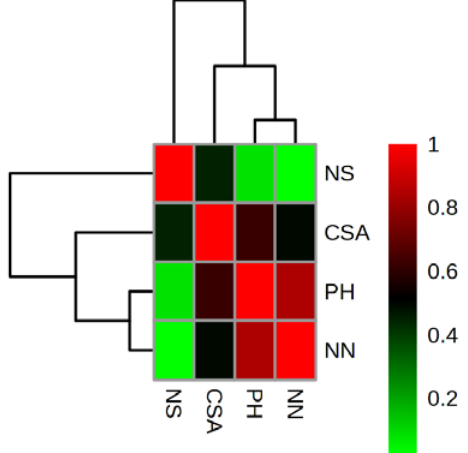
Figure 5. Heat map correlation among the in vitro morphological parameters (plant height (PH), number of nodes (NN), number of shoots (NS), and canopy surface area (CSA)) during in vitro prolonged culture of cannabis explants derived from different parts of the greenhouse-grown mother plant.